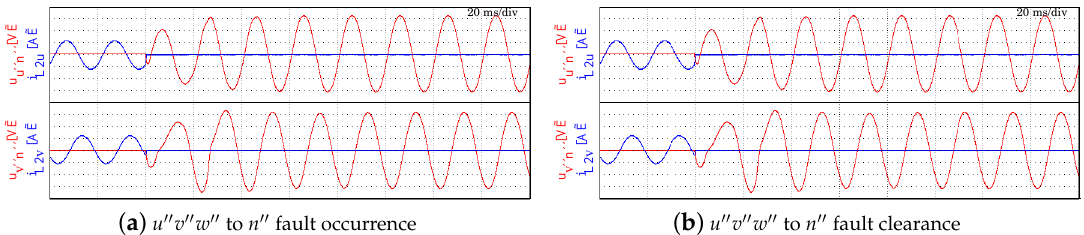
Figure 21. Scenario 4 (three-phase to neutral short-circuit). u x (cid:48)(cid:48) n (cid:48)(cid:48) (100 V/div) and i L 2 x (150